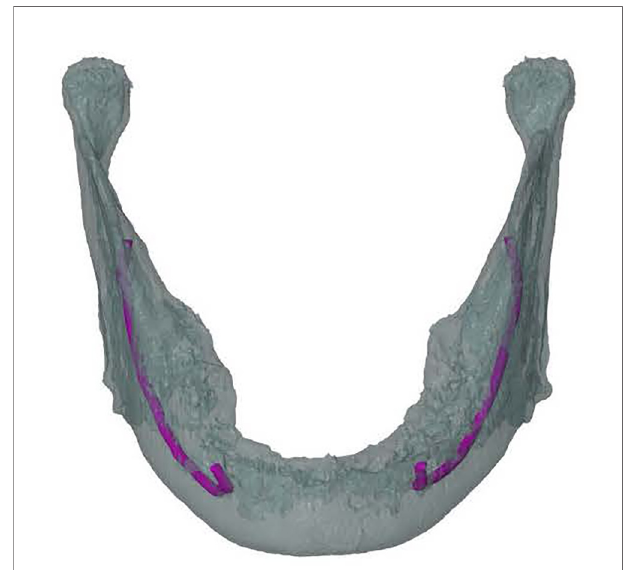
FIGURE 2 | Frontal view of a 3D model of the mandible including inferior alveolar nerve tracing (in purple) on the left and the